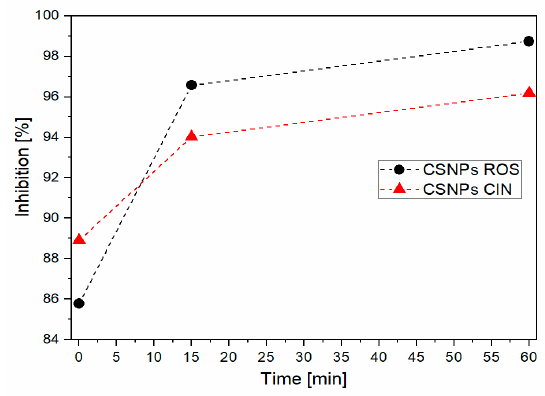
Figure 7. Antioxidative activity of CSNPs dispersions.